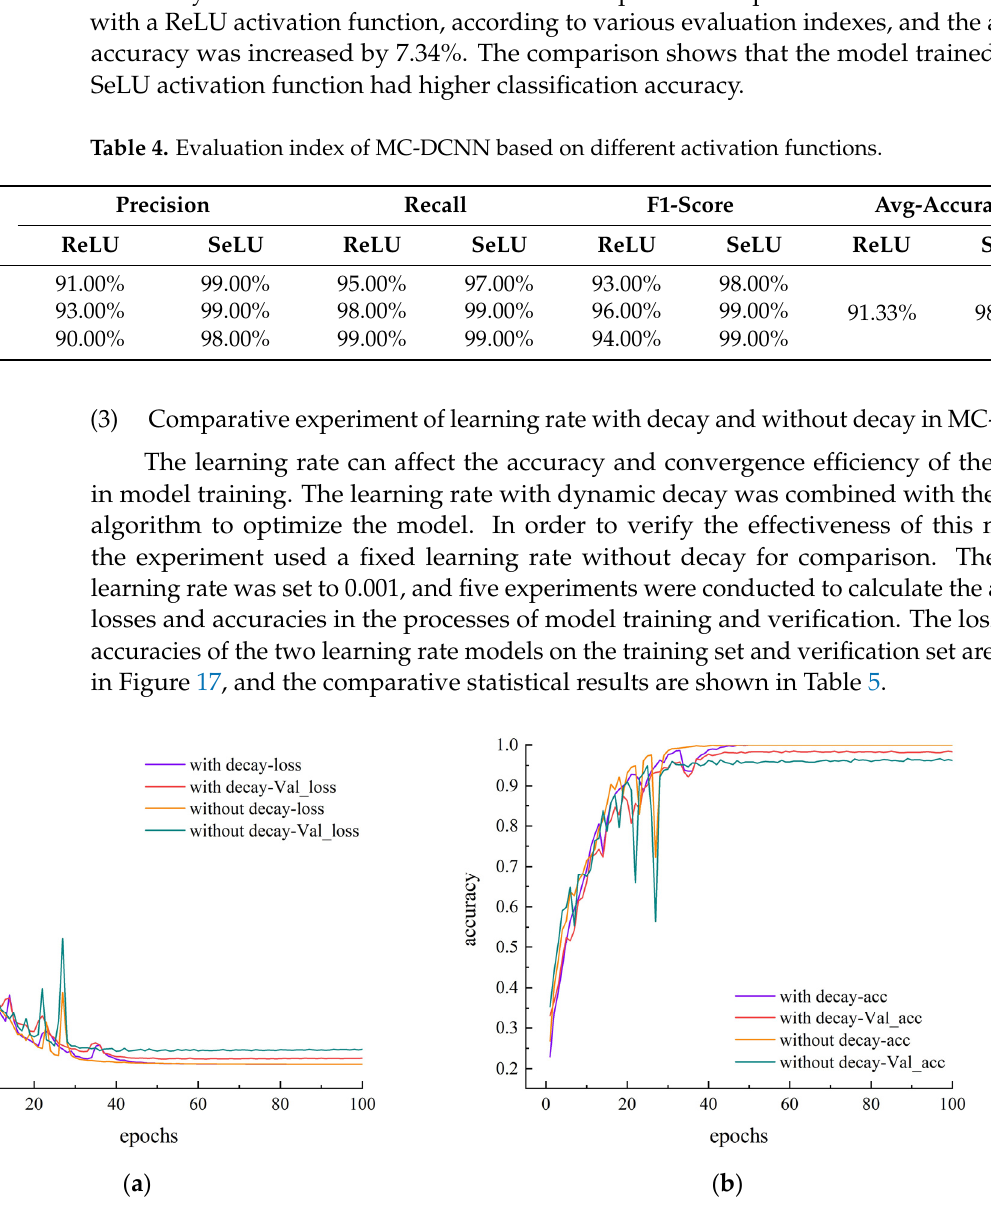
Figure 17. Convergence curves of the model at fixed and decaying learning rates: ( a ) loss; ( b ) accu- racy. Table 5. Comparison of model effects based on different learning rates.